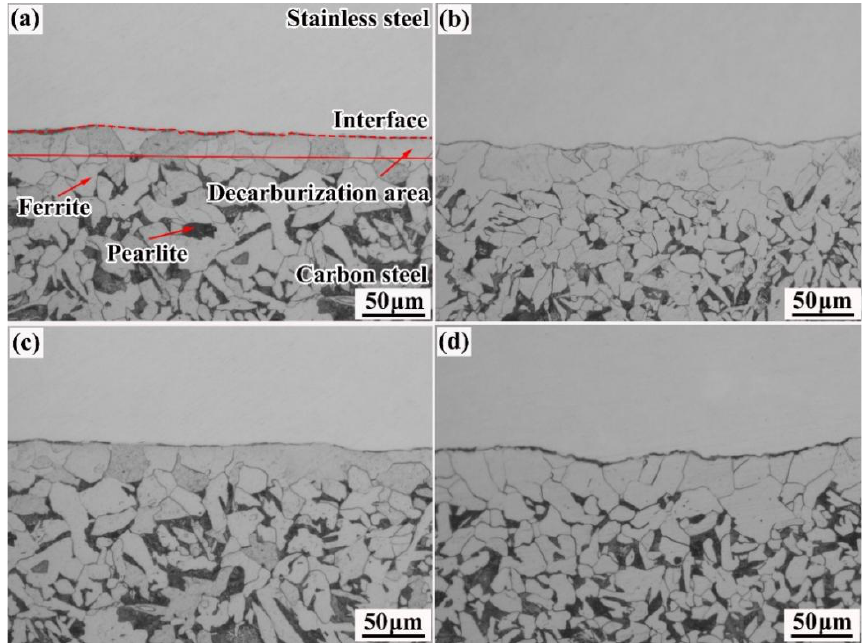
Figure 7. Metallographic images of the carbon-steel side of various rebars: ( a ) 20MnSiV/316L rebar; ( b ) 35#/316L rebar; ( c ) 45#/316L rebar; ( d ) 55#/316L rebar.